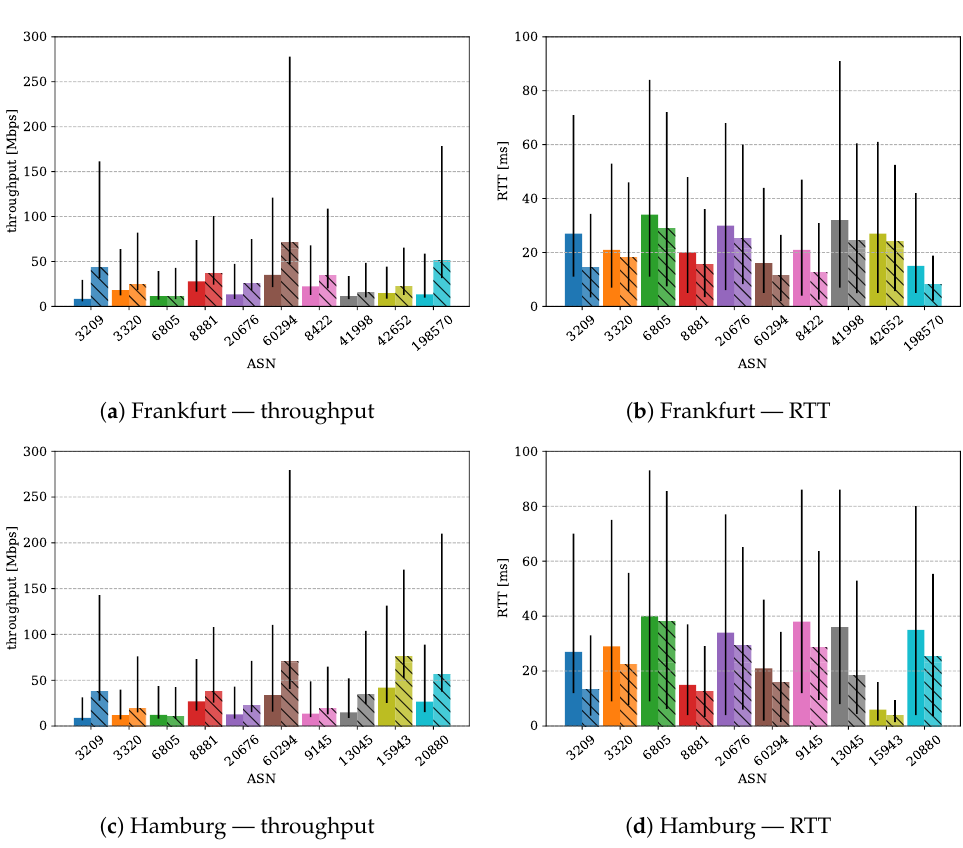
Figure 8. Throughput and RTT comparison of ISPs in Hamburg and Frankfurt for January 2020 and August 2021 (hatched